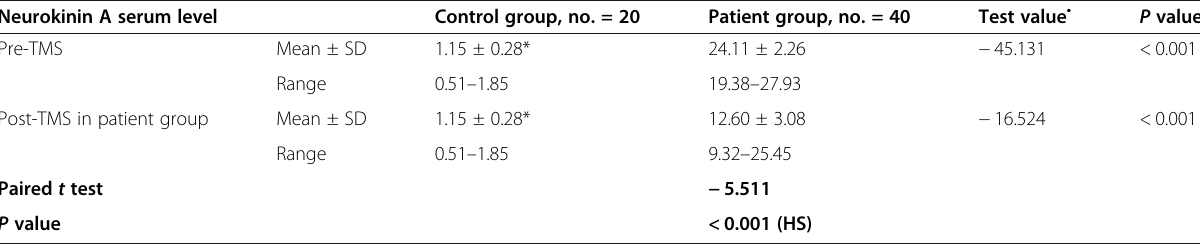
Table 2 Comparison between the patient group (pre-TMS) and control group as regards neurokinin A serum level, and comparison between pre-TMS and post-TMS treatment neurokinin A serum level in the patient group Neurokinin A serum level Control group, no. = 20